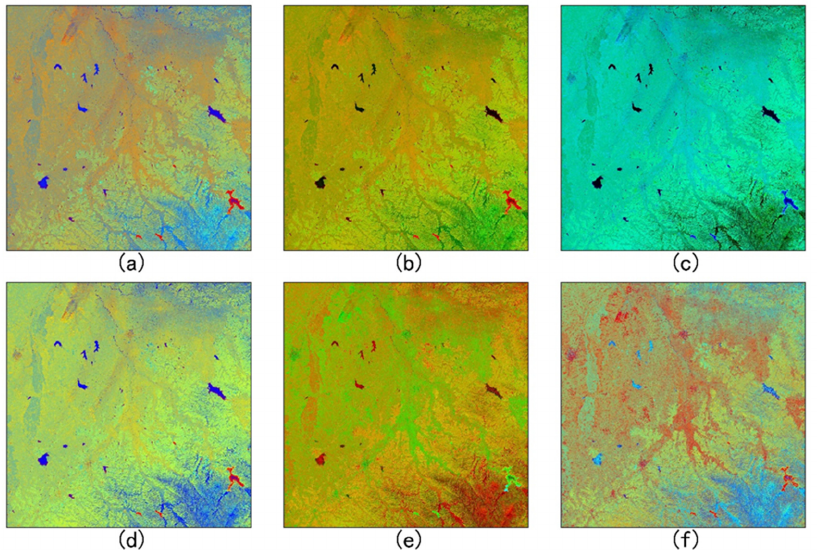
Figure 4. Synthetic images for different combinations of index: ( a ) MNDFI − NDVI − NBR, ( b ) NDVI − MNDFI − BAI, ( c ) BAI − MCRC − MNDFI, ( d ) MNDFI − MCRC − NBR, ( e ) NDTI − MNDFI − BAI, and ( f ) MNDFI − NDTI − NBR.